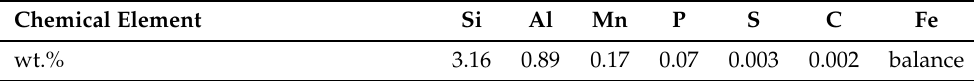
Table 1. Chemical composition of the investigated non-oriented electrical steel in the case studies. Chemical